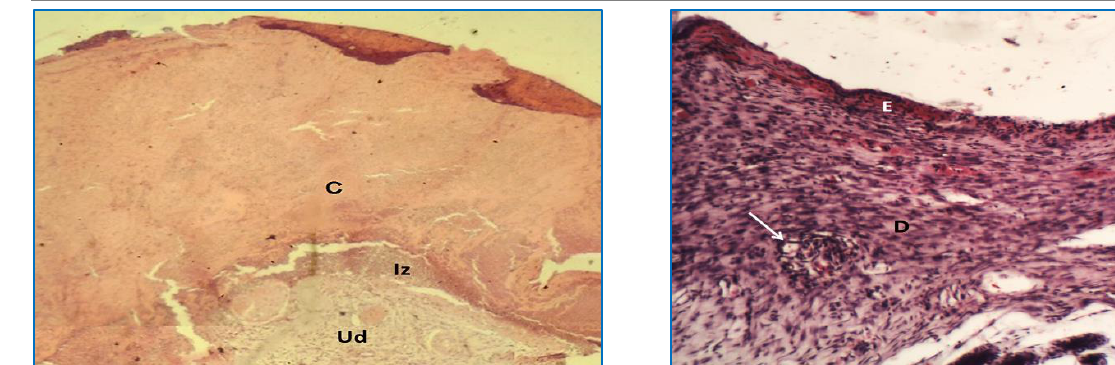
Figure, 7: Section of skin (7 days post treatment with pericardial craft) shows thick fibrin clot (C), inflammatory zone (Iz), and underlying dermis (Ud). H and E, 40x.